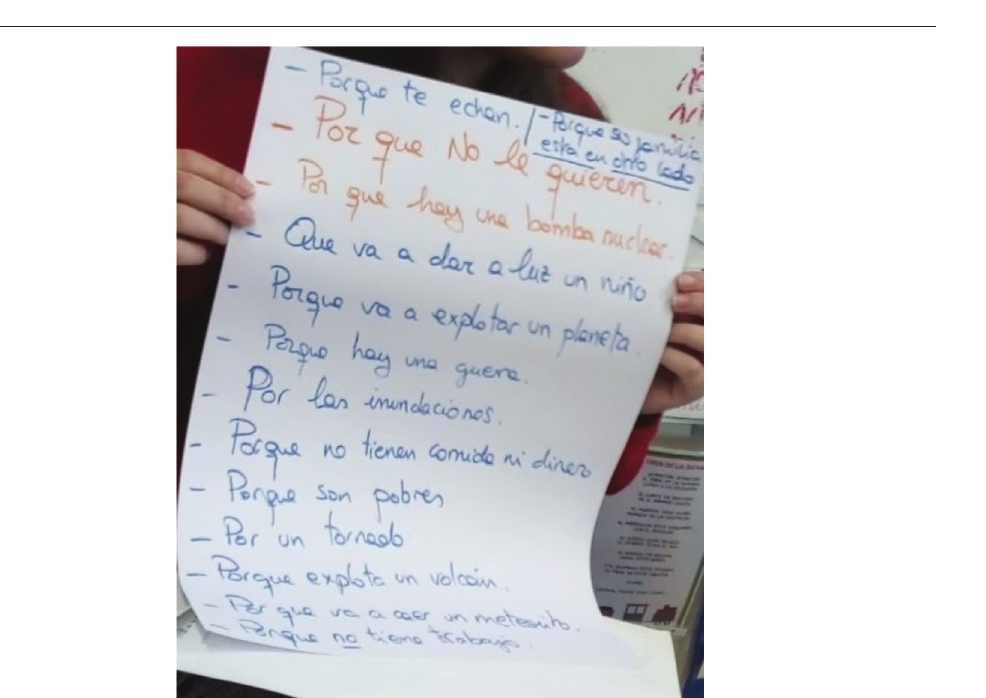
Figure 1: Answers given by pupils to the question of why they thought a person would leave their country (Photograph: Author,